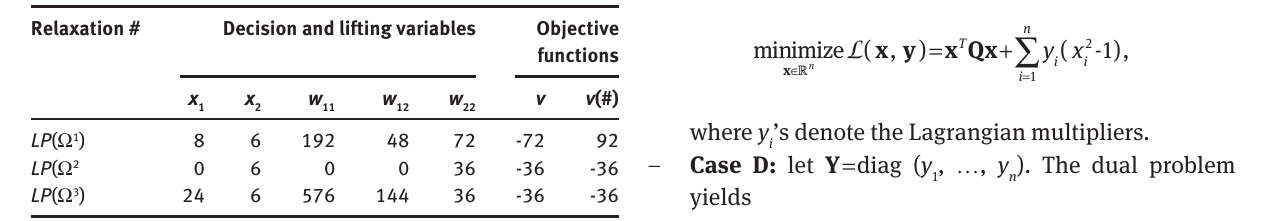
Table A2: Successive relaxation steps in Example A1.